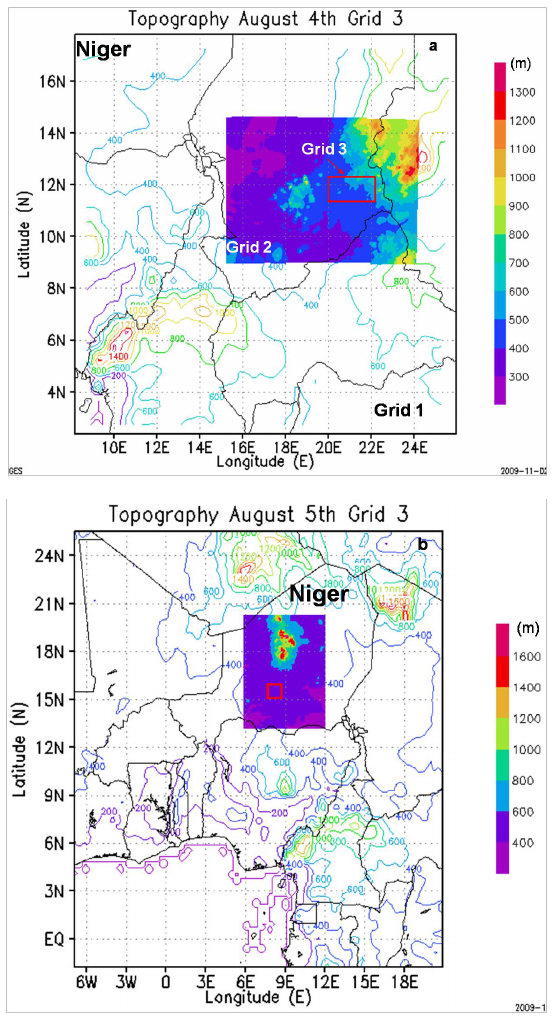
Fig. 6b Fig. 6. Topography of the 3 nested grids used for the BRAMS sim- ulation (iso-lines for Grid 1, and shaded contour for grids 2 and 3). (a) Chad case. (b) A¨ır